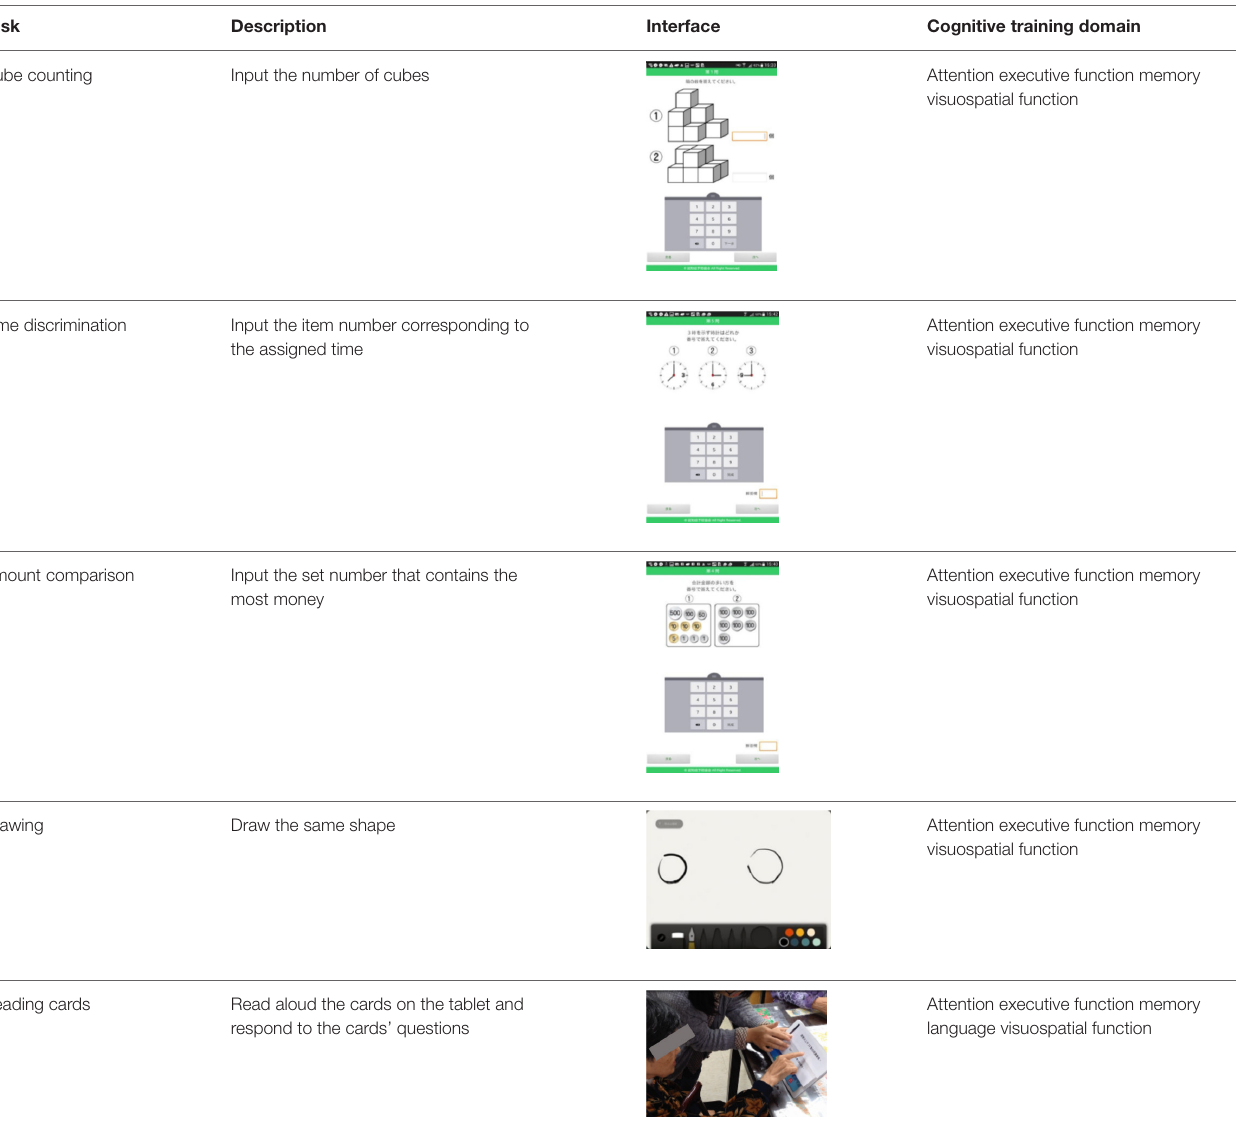
TABLE 3 | Contents of acceptance